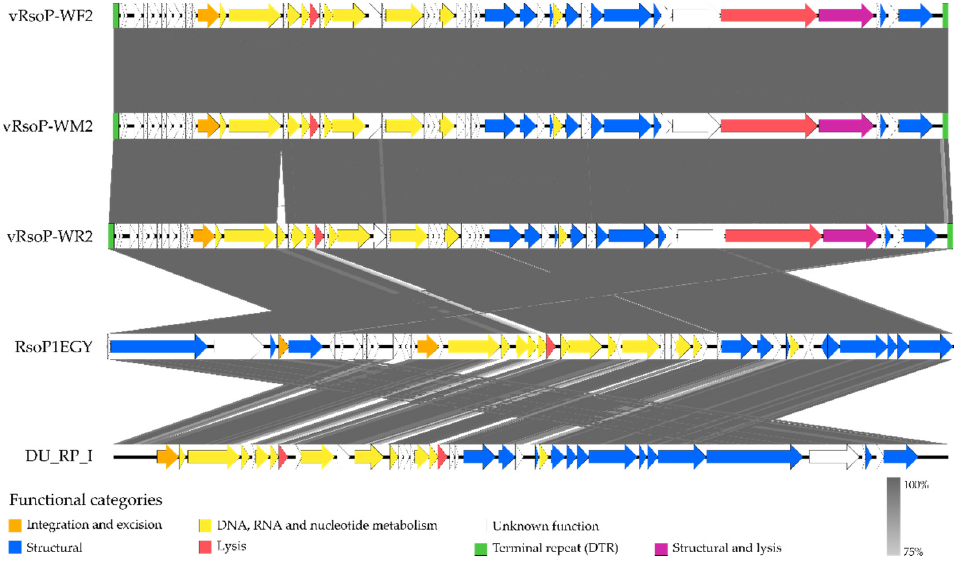
Figure 3. Genomic organization of the three European R. solanacearum phages together with the closest phages RsoP1EGY and DU_RP_I. Open reading frames (ORFs) are shown using arrow symbol, which indicates the direction of transcription. Genes grouped in different functional categories are shown in different colours according to the legend below the map. The categories of the phage proteins of RsoP1EGY and DU_RP_I were extracted from the PHROG database [61]. The genomic map was generated with the genome comparison visualiser EasyFig 2.2.5 [62]. Table 2. Characteristics of the genomes of the European R. solanacearum phages. ORF Number Predicted Function vRsoP-WF2